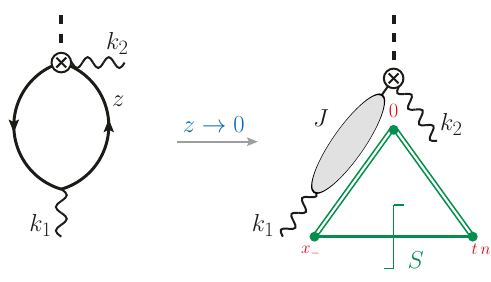
Figure 4 . Graphical illustration of the refactorization condition for [[ h O (0)